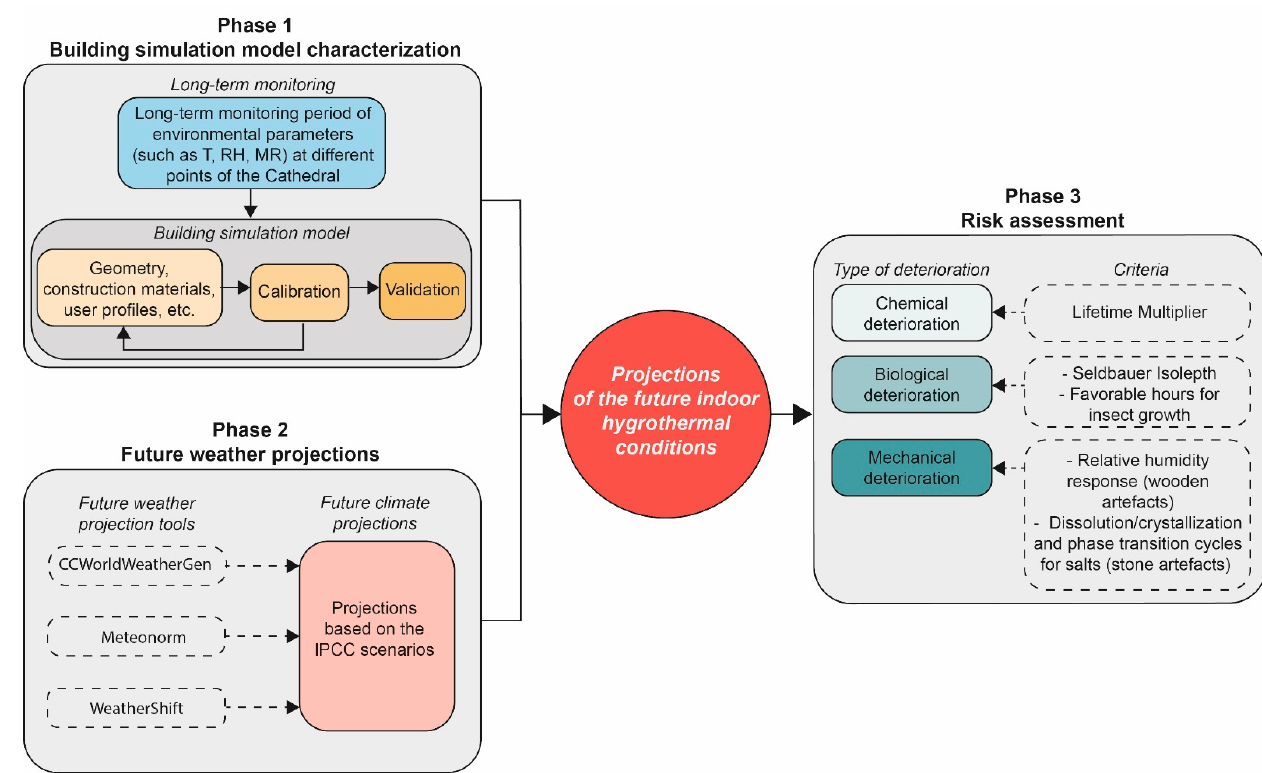
Figure 1. Phases of the adopted method.